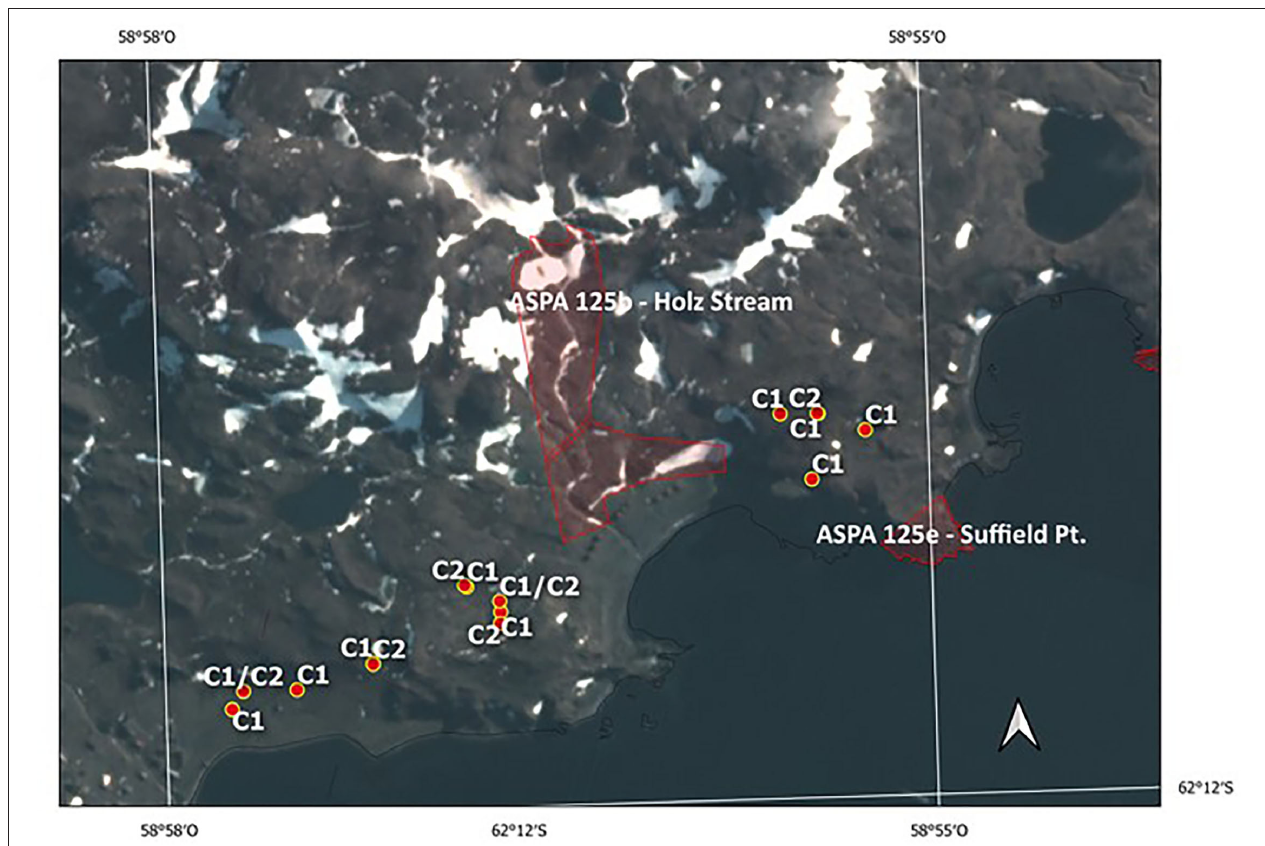
FIGURE 5 | Current boundaries of ASPA 125b—Holz Stream and 125e—Suffield Point and locations of vulnerable moss sites. C1 corresponds to Cluster 1 and C2 to Cluster 2,